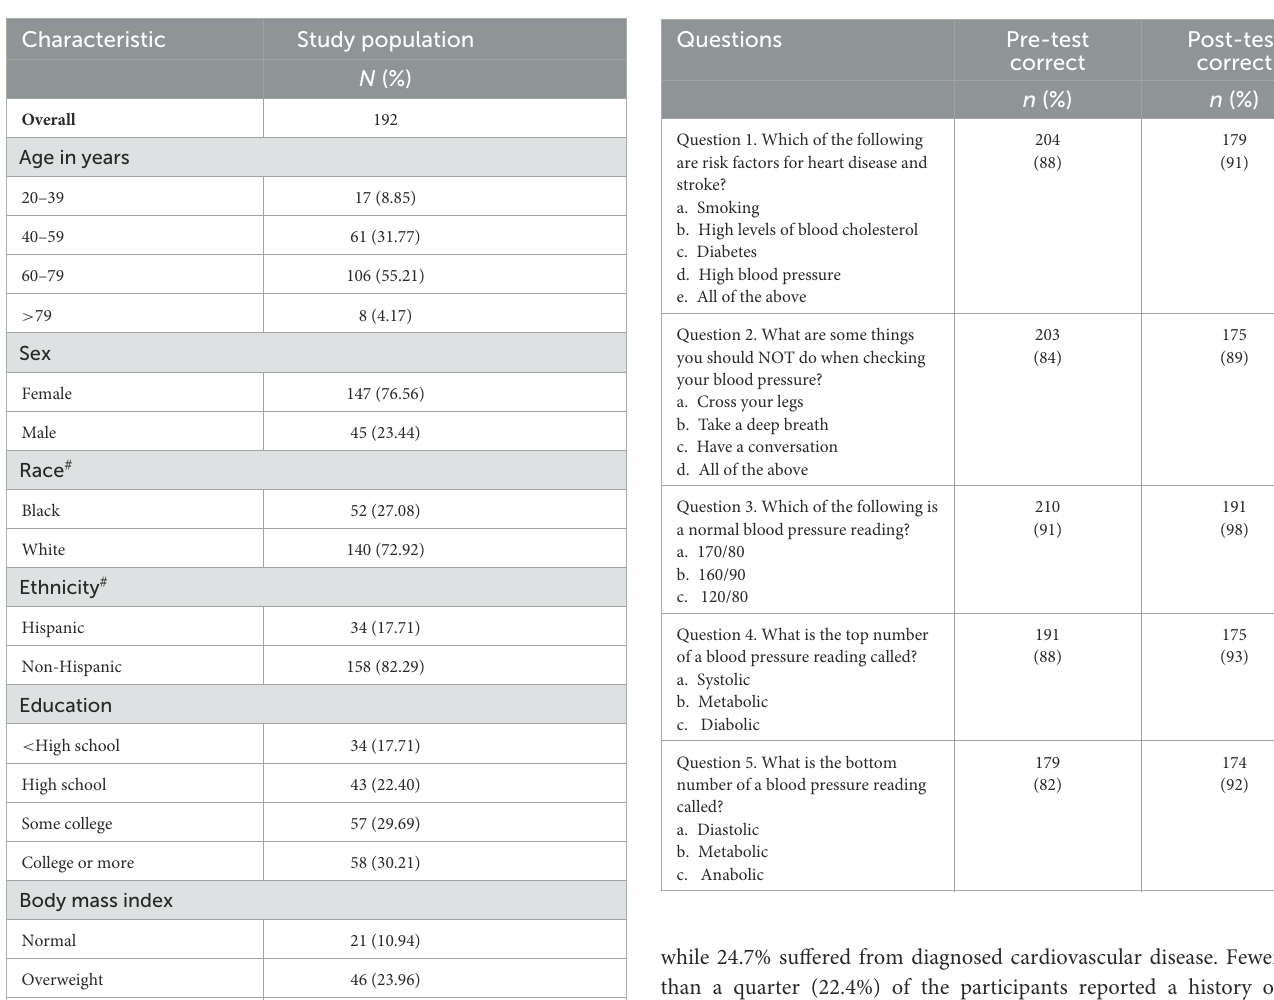
TABLE 1 Characteristics of study participants. TABLE 2 Participant pre-test/post-test hypertension